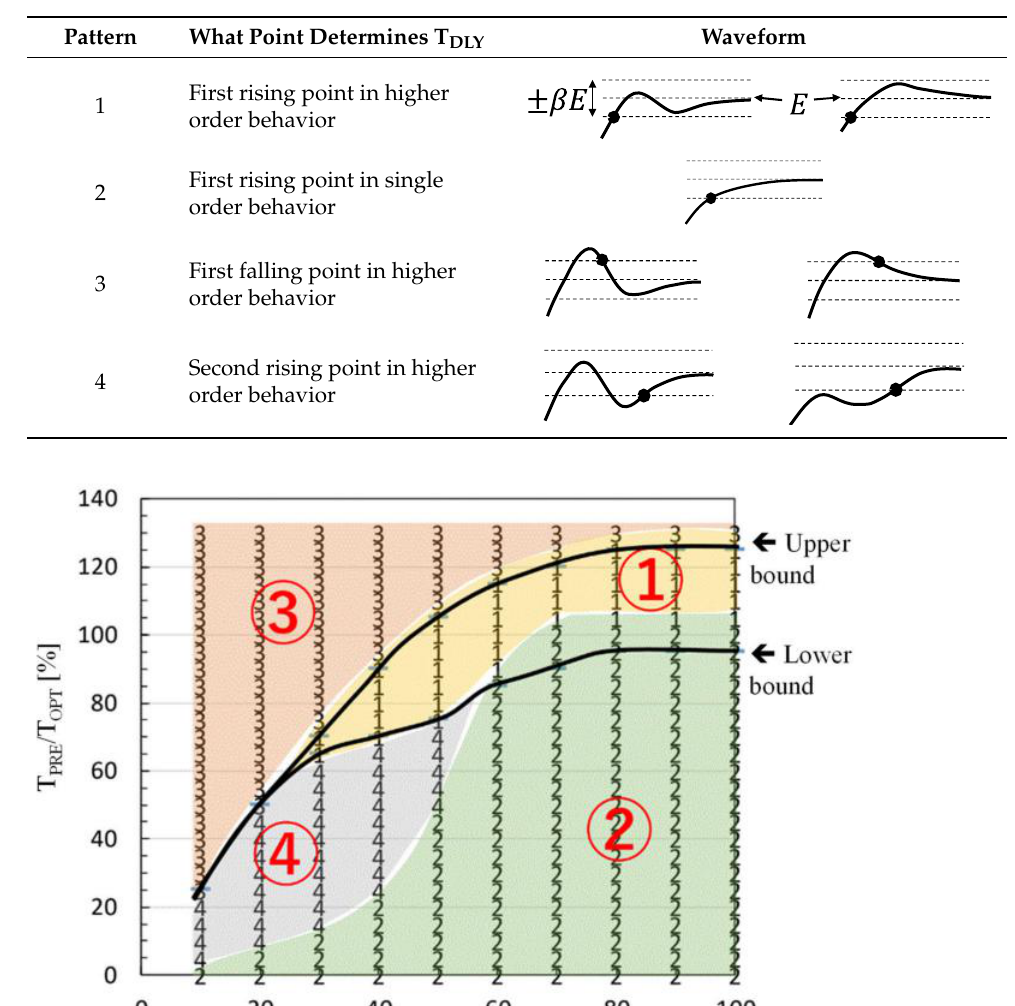
Table 1. WL waveform pattern.